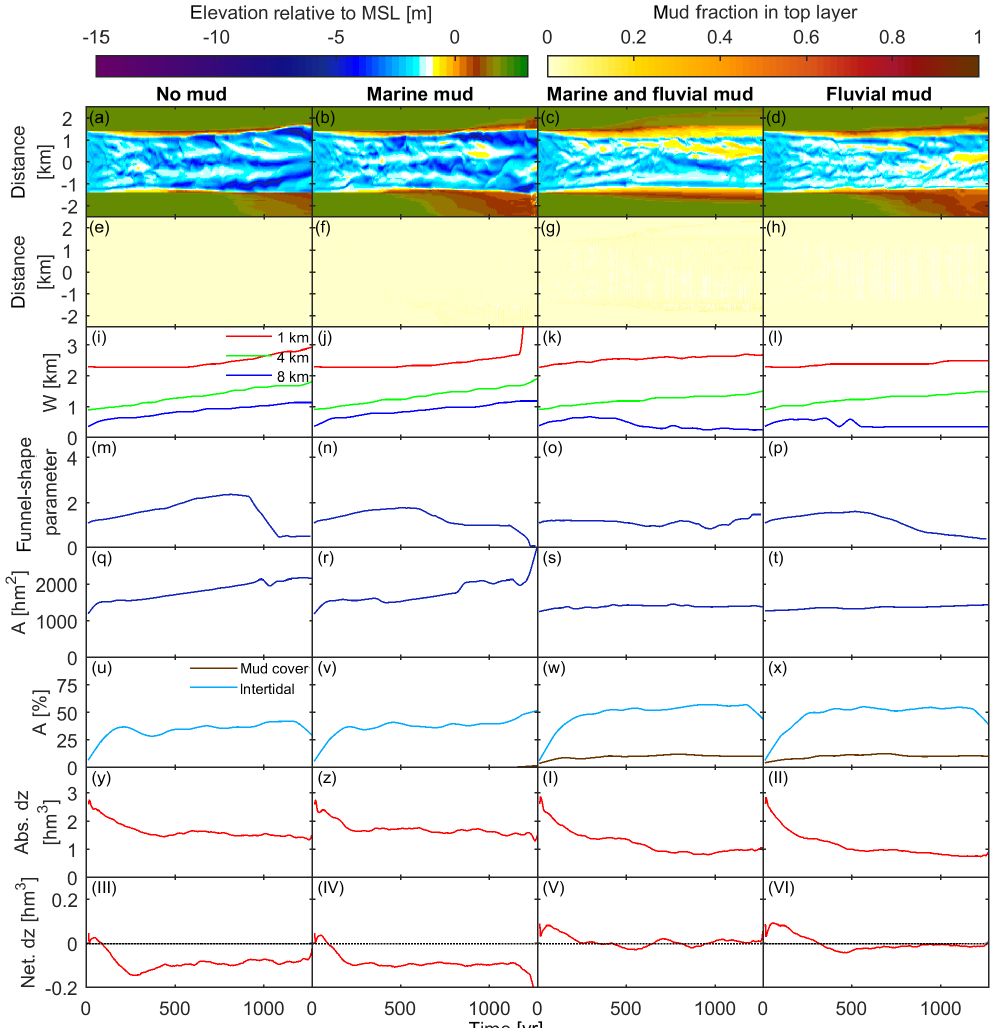
Figure A12. Hydrodynamics and morphodynamics over time for estuaries for different mud sources in the presence of waves. From left to right (columns): model with only sand (28), marine mud supply (27), supply from both boundaries (25) and fluvial supply (29). (a– d) Bathymetry of the cross section at the mouth plotted over time, (e–h) mud fraction in the top layer of the cross section at the mouth, (i–l) estuary width at 1, 4 and 8km from the mouth, (m–p) funnel-shape parameter, (q–t) estuarine surface area, (u–x) intertidal area and mud in the bed relative to the total area, (y–II) absolute bed level change and (III–VI) net bed level